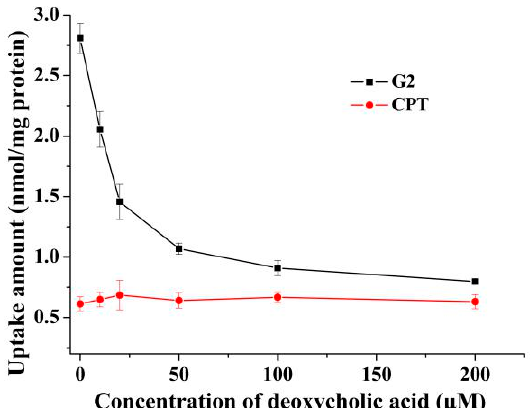
Figure 3. The effect of deoxycholic acid on uptake of G2 and CPT in HepG2 2D cell model. After pretreatment with different concentrations of deoxycholic acid for 0.5 h, cells were incubated with 10 µ M G2 or CPT for 2 h and the amount of uptake was detected. Results are presented as mean ± SD of three independent measurements.